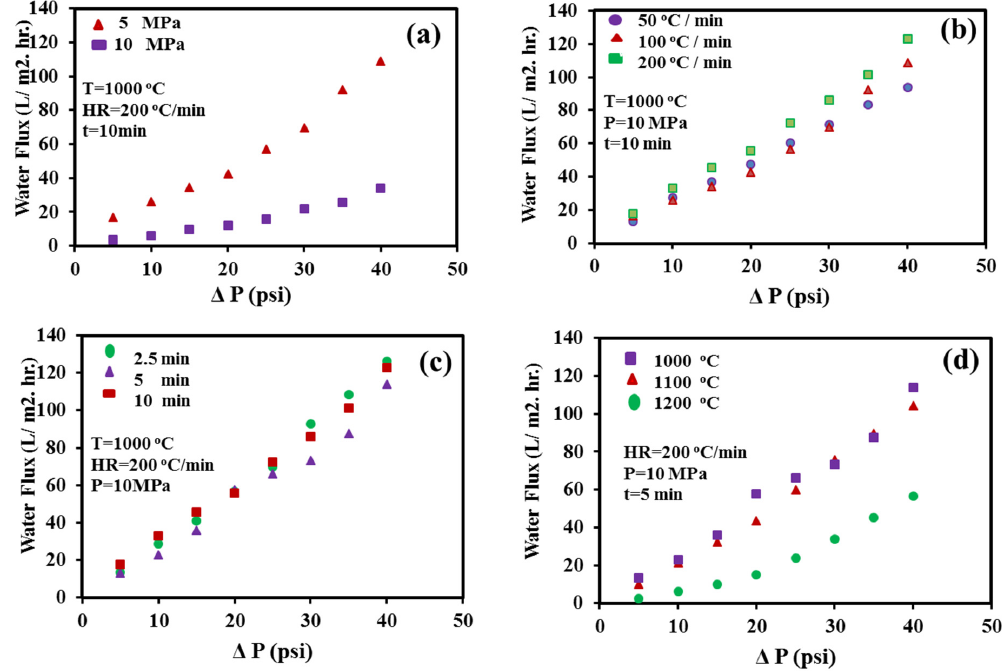
Figure 7. Variation in pure water flux under different transmittance pressures for membranes prepared with varying SPS process parameters: ( a ) pressure, ( b ) heating rate, ( c ) holding time, and ( d ) temperature.